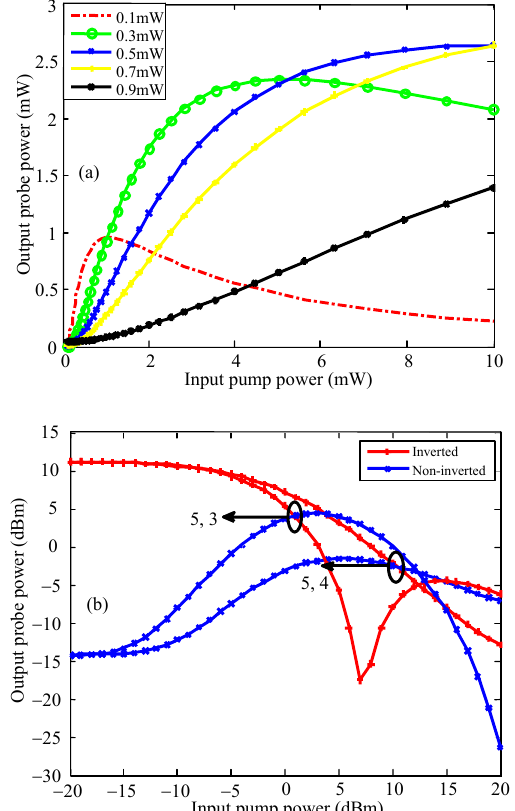
Fig. 2 Output power with respect to the pump power: (a) input probe light power and (b) linewidth enhancement